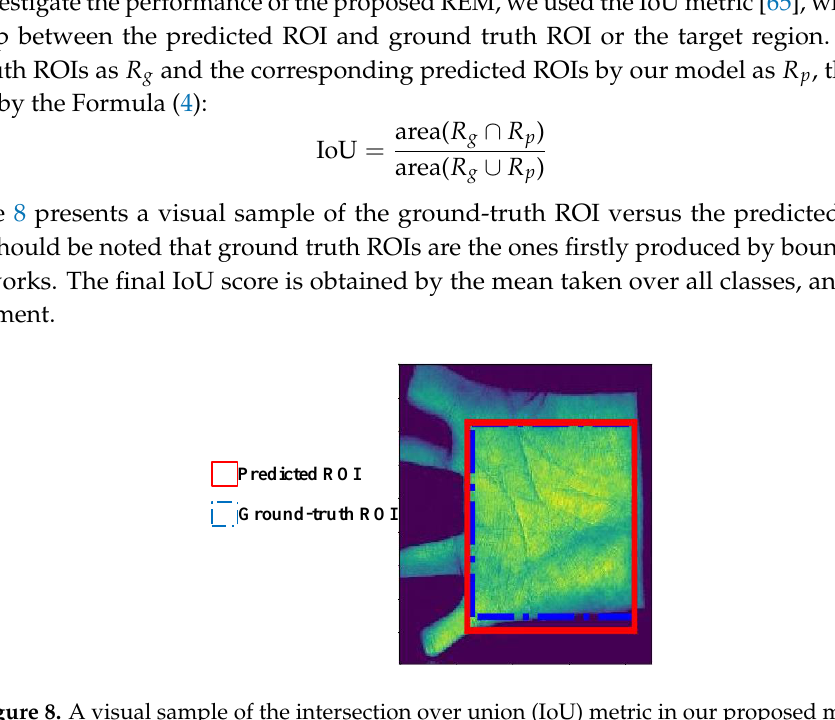
Figure 8. A visual sample of the intersection over union (IoU) metric in our proposed model.